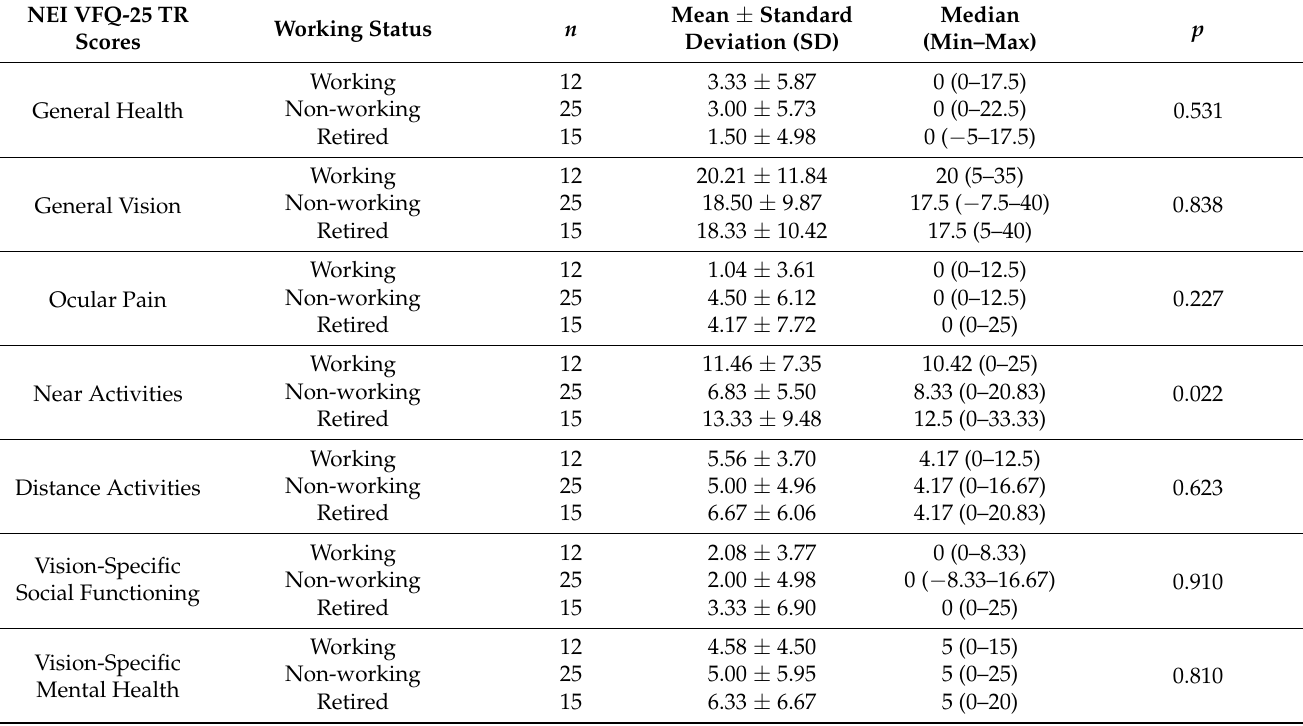
Table 6. Summary of the changes in NEI VFQ-25 TR subscale and composite scores after treatment (1 month after the third injection) according to working